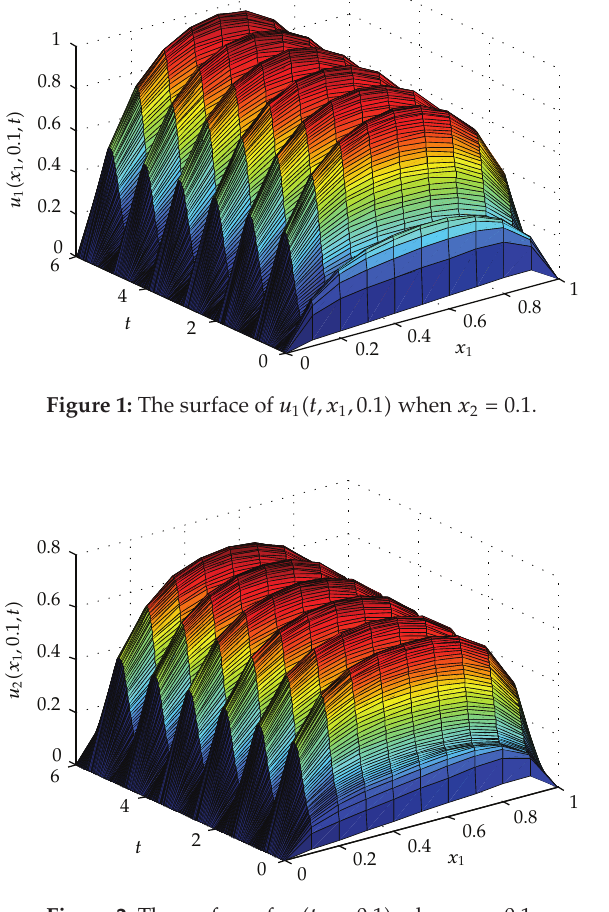
Figure 2: The surface of u 2 (cid:3) t,x 1 , 0 . 1 (cid:4) when x 2 (cid:8) 0 . 1.